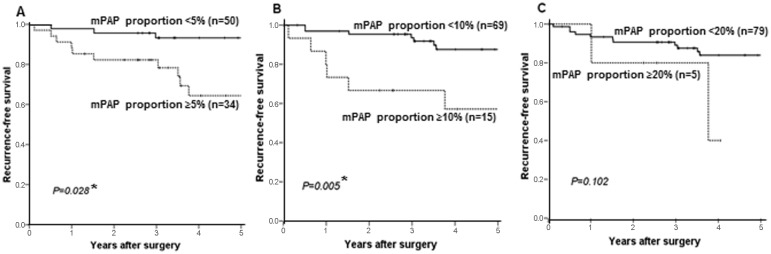
Kaplan-Meier recurrence-free survival curves of the association between the proportion of micropapillary (mPAP) element and disease recurrence in patients with stage I EGFR-mutated lung adenocarcinomas.A, tumors in which the mPAP element accounted for ≥5% of the tumor versus (vs) those in which the mPAP element accounted for <5% of the tumor (P = 0.028 in the Log-rank test); B, tumors in which the mPAP element accounted for ≥10% of the tumor vs those in which the mPAP element accounted for <10% of the tumor (P = 0.005 in the Log-rank test); C, tumors in which the mPAP element accounted for ≥20% of the tumor vs those in which the mPAP element accounted for <20% of the tumor (P = 0.102 in the Log-rank test); n, number of tumors examined; asterisk(*), statistically significant.